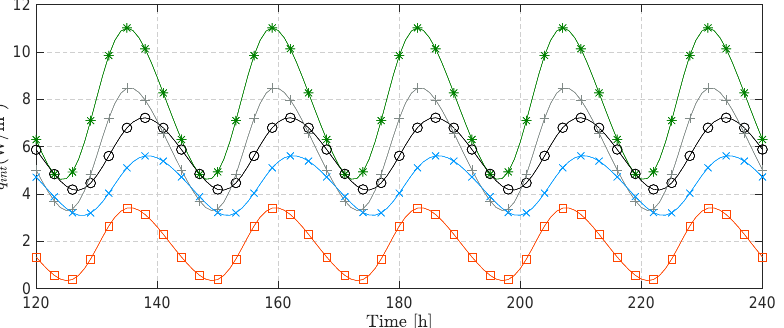
Figure 13. Heat flux distribution over time at the interior surface: ( ∗ ) no canopy, k s = 0.6, e = 0.10 m; ( ◦ ) no canopy, k s = 0.6, e = 0.15 m; (+) k s = 0.6, e = 0.10 m; ( × ) k s = 0.6, e = 0.15 m; ( (cid:3) ) k s = 0.9, e = 0.10